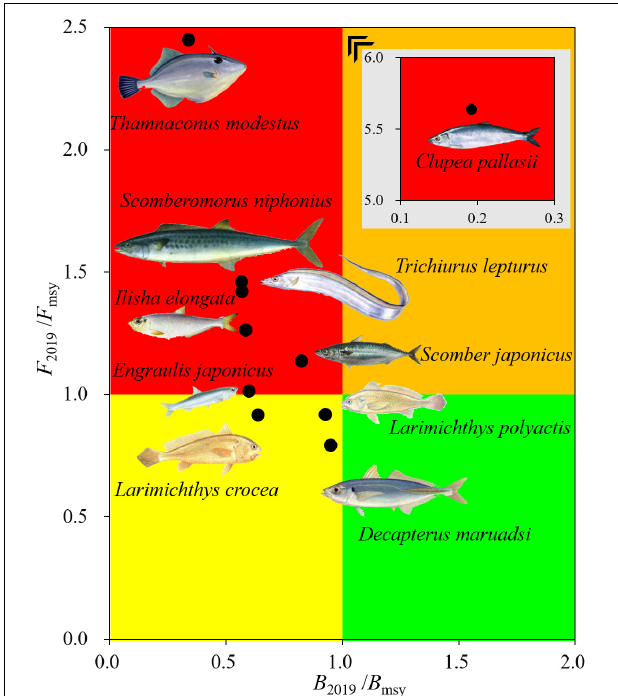
FIGURE 2 | Fishing pressure Kobe plot for the fishes in 2019 based on current exploitation status ( B 2019 / B msy ) and remaining level of exploitation ( F 2019 / F msy ). The red area indicates the worst conditions of overexploited stocks under overfishing; the yellow area indicates recovering of overexploited stocks from reduced fishing pressure; the green area indicates a healthy stock size with sustainable fishing pressure; and the brown area indicates healthy stock sizes but facing